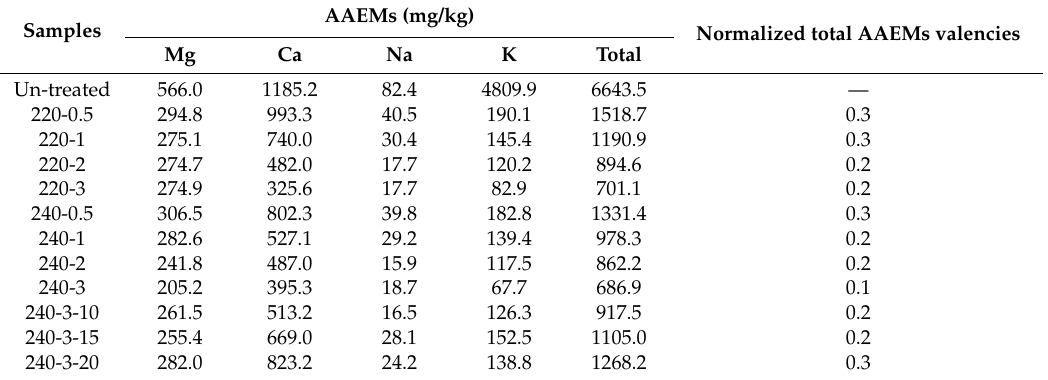
Normalized total AAEMs valencies